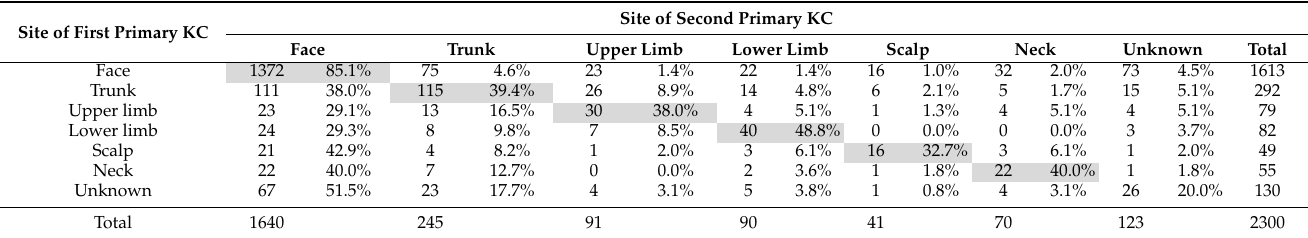
Table 3. Location of non-melanoma skin cancers.